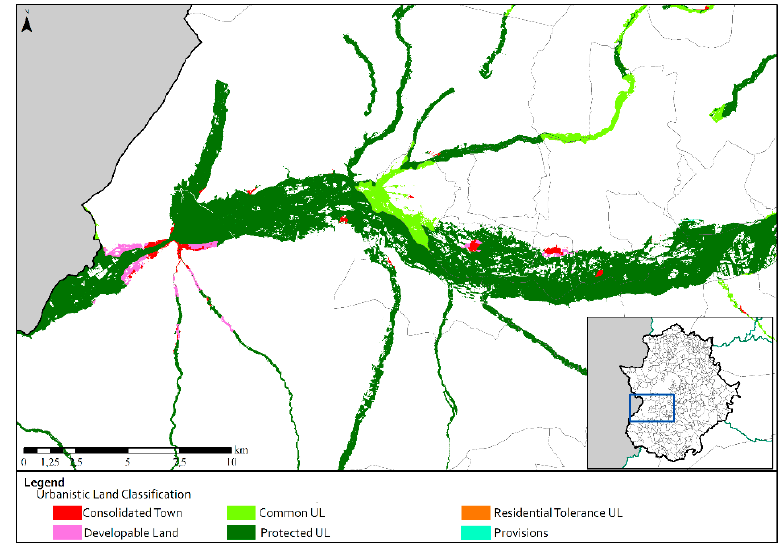
Figure 3. Urban classification of flood zones.